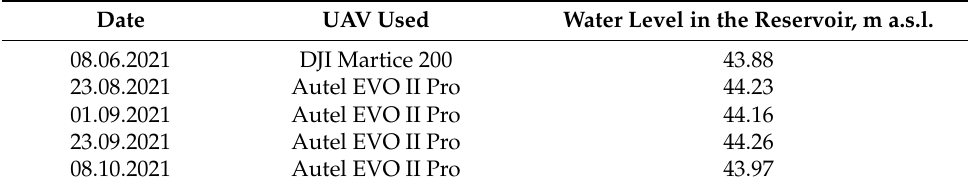
Table 1. Performed flight missions with the UAVs.